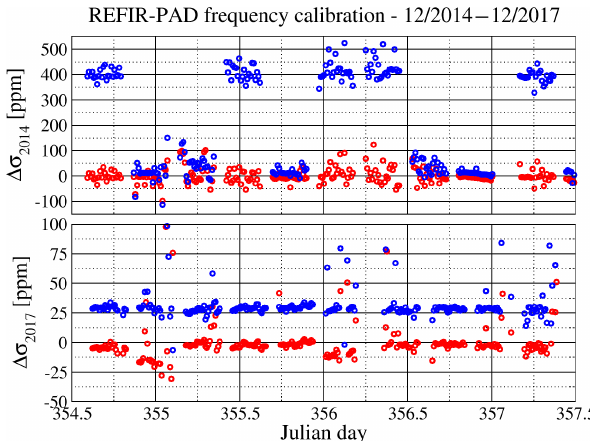
Figure 9. Result of the line fitting process used to perform auto- matic frequency calibration of the REFIR-PAD measured spectra.